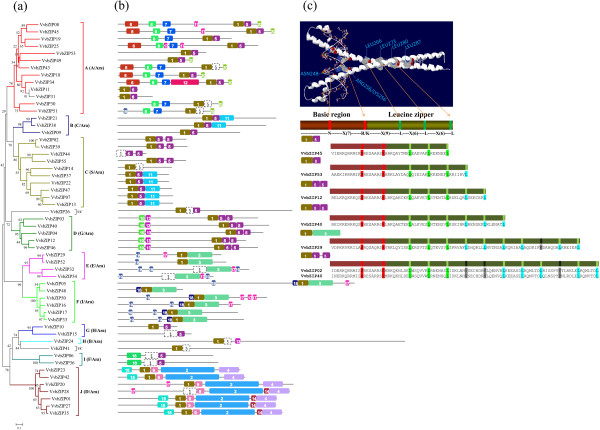
Conserved motifs of VvbZIP proteins. All conserved motifs of the VvbZIP proteins were identified by the MEME program. The protein structures (b) of VvbZIPs based on the presence of conserved motifs were arranged corresponding to the phylogenetic tree (a) of the VvbZIP proteins. Different motifs are highlighted with different colored boxes with numbers 1 to 20. Among them, the motif 1, 5, 9 and 13 mainly represented variations in the bZIP domain and the unusual motifs is shown in white. The sequence details of these conserved motifs are given in Additional file 3. The 3D structure and the variation of Leucine zipper region of VvbZIP proteins in length were described in (c).